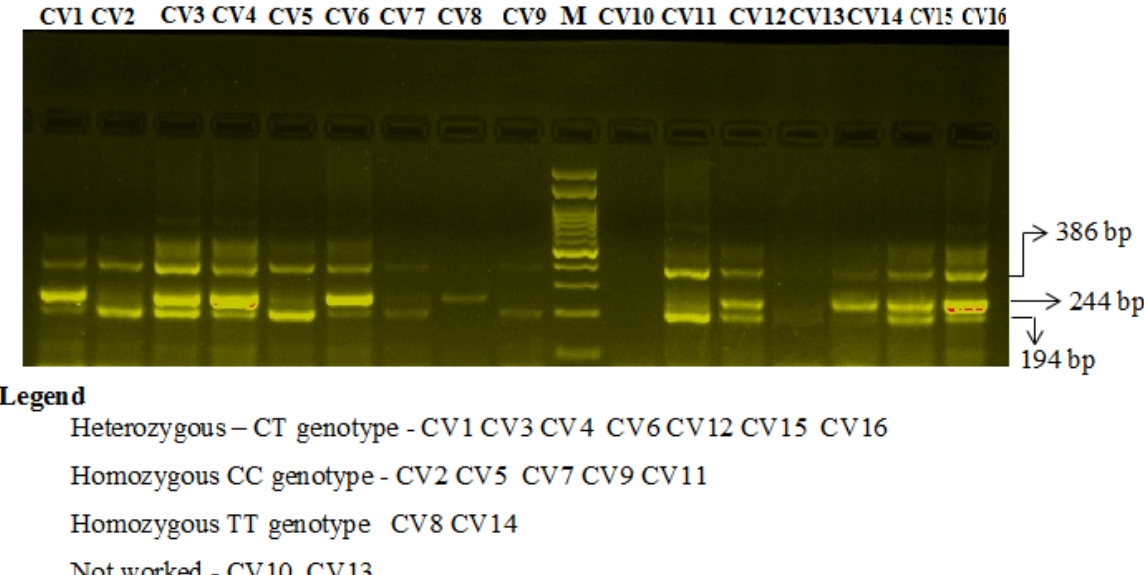
Figure 2. Two percent gel electrophoresis of angiotensin-converting enzyme 2 (ACE2) rs4240157 C/T genotyping by the amplification-refractory mutation system (ARMS) in COVID-19 cases.